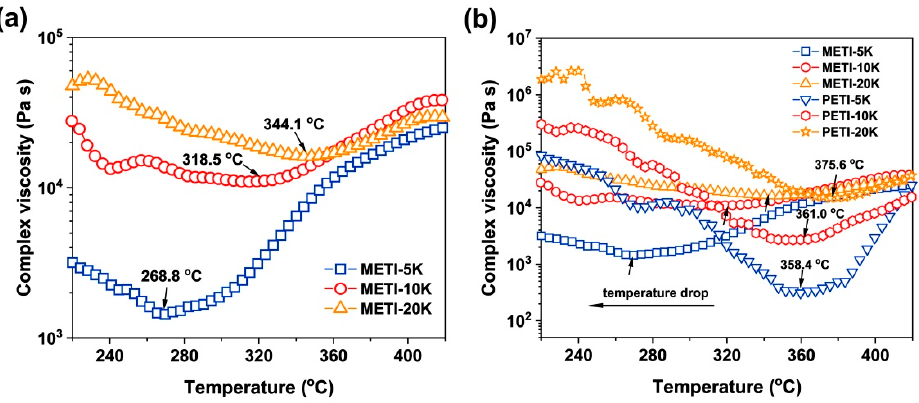
Figure 8. Rheological curves of three molecular weight resins: ( a ) METI; ( b ) METI and PETI.